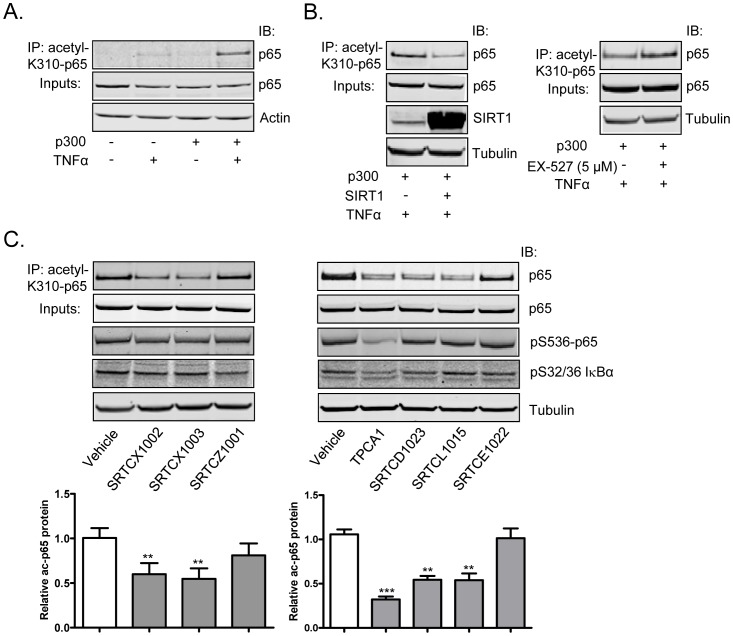
STACs attenuate TNFα-induced p65 acetylation.(A) Western blots of immunoprecipitated acetylated K310-p65 protein, p65 and actin protein in whole cell lysates from vector or p300 transfected cells with or without TNFα stimulation. (B) Left panel, western blots of immunoprecipitated acetylated K310-p65 protein, SIRT1, p65 and tubulin in whole cell lysates from TNFα-stimulated cells transfected with p300 plus empty vector or p300 plus SIRT1. Right panel, western blots of immunoprecipitated acetylated K310-p65 protein, p65 and tubulin in whole cell lysates from TNFα-stimulated p300 overexpressing cells that were pretreated with EX-527 for 6 hours. (C) Upper panels, western blots of immunoprecipitated acetylated K310-p65 protein, p65, phospho-NF-κB (Ser536), phospho-IκBα (Ser32/Ser36) and tubulin in whole cell lysates from cells pretreated with compounds for 6 hours followed by 20 minutes TNFα stimulation. Lower panels, densitometry quantitation of the western blot for immunoprecipitated acetylated p65 protein. The level of acetylated p65 in TNFα-stimulated and vehicle treated sample was set as 1. Experiments were repeated at least 2 times and western blots from one experiment were shown as representative. Error bars present s.d. of densitometry quantitation of western blots from at least two experiments. *P<0.05, **P<0.01 and ***P<0.001.